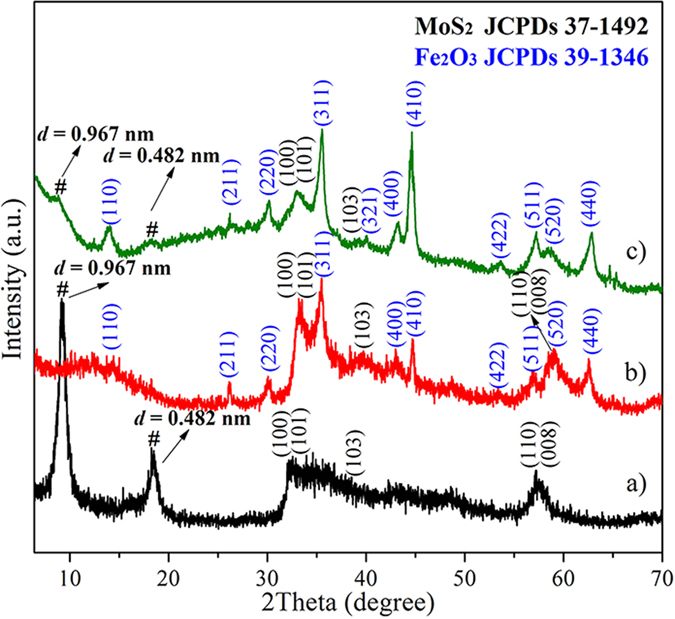
XRD patterns.(a) MoS2 nanosheets, (b) Fe2O3/MoS2 composite and (c) the physical mixture Fe2O3+MoS2.